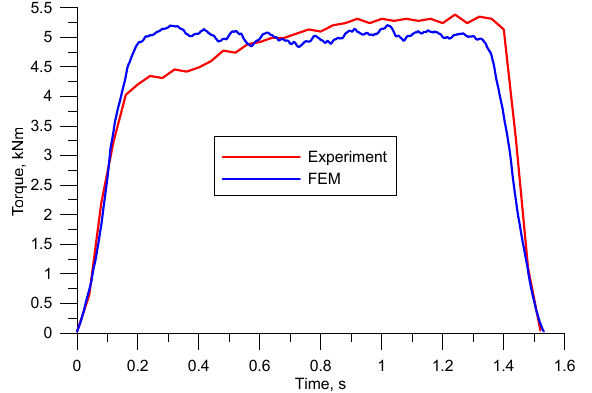
Figure 18. Distribution of torques during longitudinal rolling of preforms from scrap rail heads.